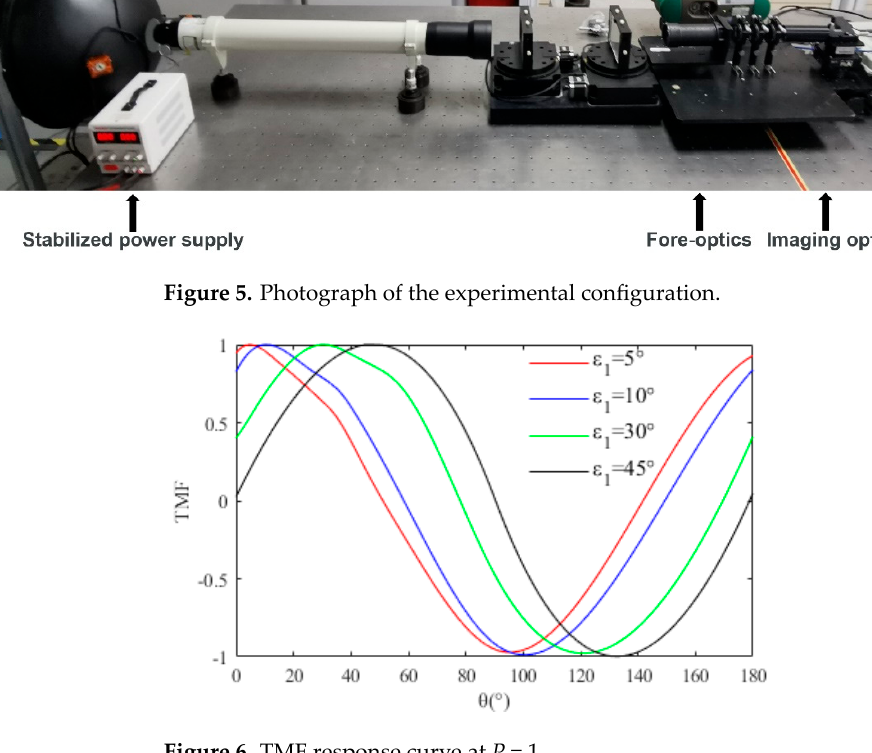
Figure 6. TMF response curve at P = 1